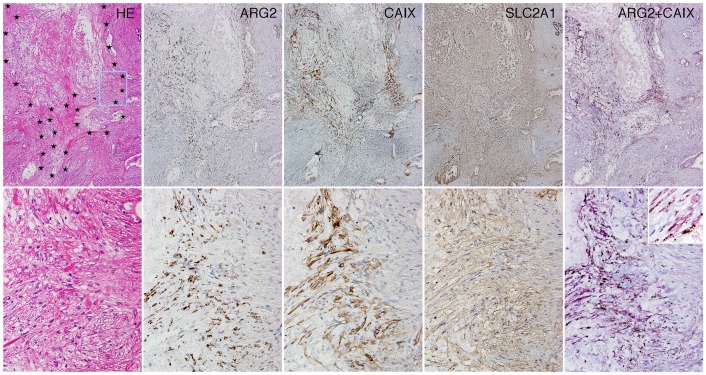
ARG2 was expressed mostly in CAFs under hypoxic conditions.Histology of PDC tissue in low- (upper columns) and high-power view (lower columns). HE staining and immunohistochemistry for ARG2, CAIX, and SLC2A1 in serial tissue sections. Necrotic areas are surrounded by star marks in the upper HE photo and the rectangle (light blue) corresponds to the area of the lower column. Double immunostaining (the right-most columns) reveals that most of the granular ARG2 staining (brown) is present in spindle-shaped cells stained for CAIX (purple). Inset is a very high-power view.